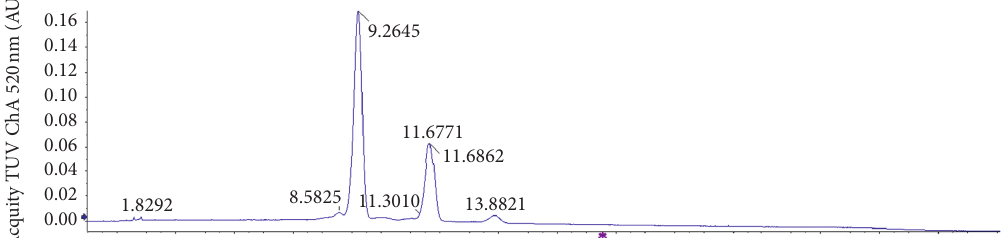
Figure 5: The HPLC chromatogram (520 nm) of